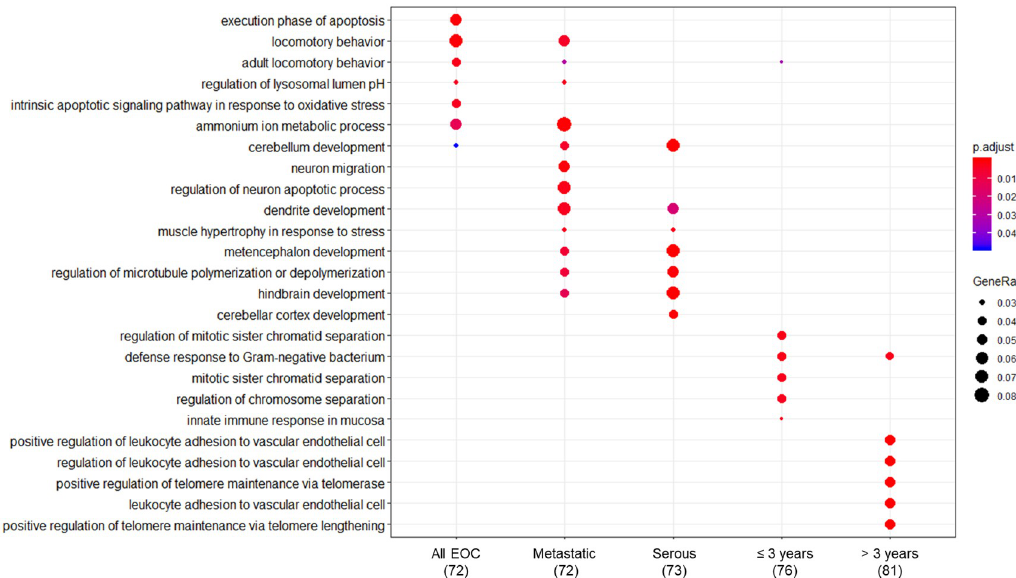
Fig 3. Gene Ontology (GO) enrichment of biological processes among the 100 probes with the lowest p-values in single-gene linear models (case-control) of blood samples from all cases of epithelial ovarian cancer (66 pairs) and according to metastasis status (56 pairs), serous subtype (45 pairs), and interval to diagnosis ( � 3 years or > 3 years; 34 and 31 pairs, respectively). Numbers below each column indicate the number of probes for which GO categories could be found. The figure presents the five GO categories with lowest p-values. Enriched GO categories (p < 0.05) beyond the top five are included in addition if they are among the five most enriched of one of the other investigated groups. S8 Table presents the complete GO enrichment